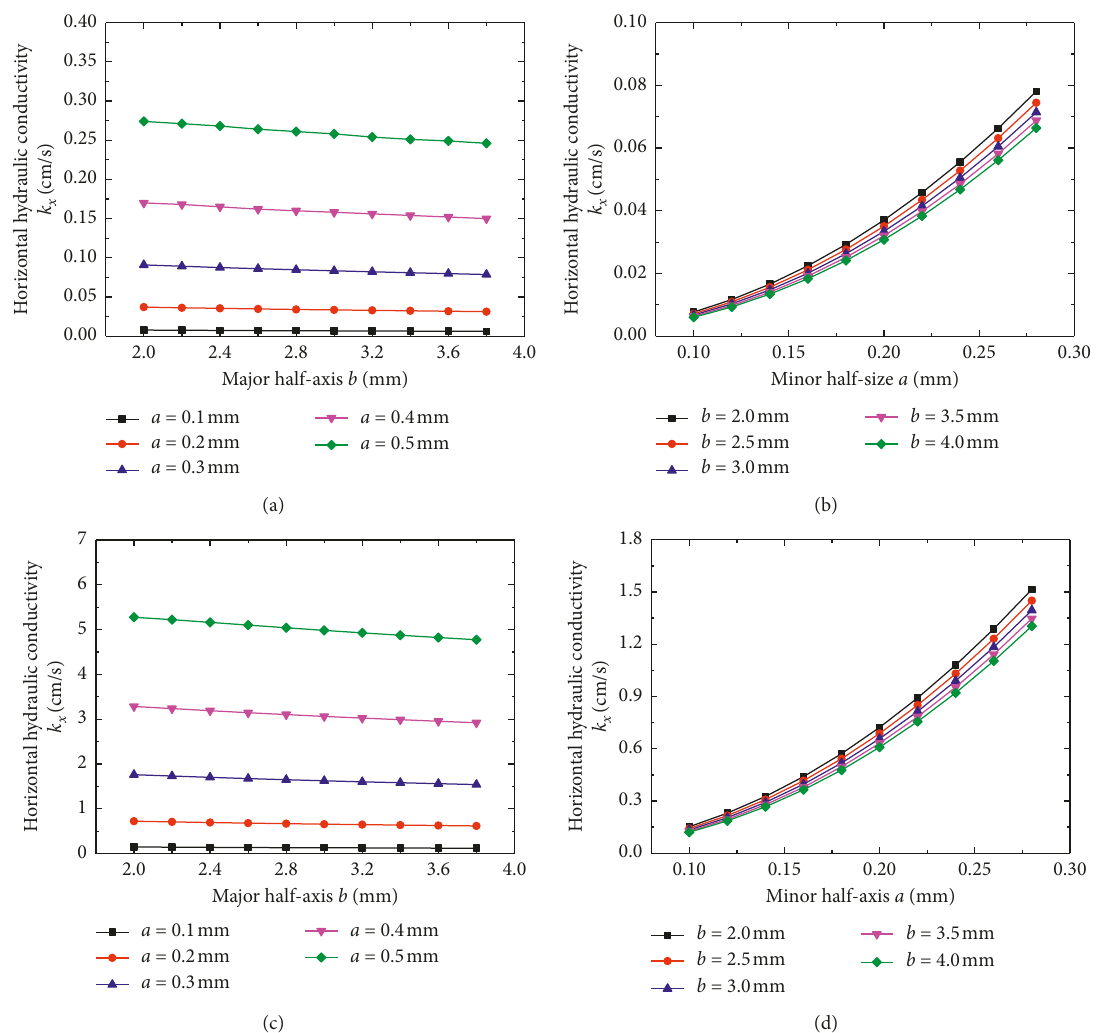
Figure 15: The changing law of hydraulic conductivity with the increasing sizes of particles under three-particle arrangement (a, b) and five- particle arrangement (c,